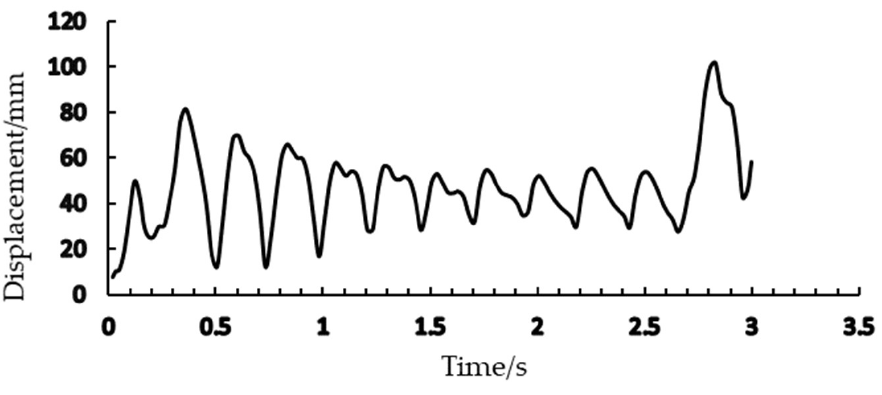
Figure 12. Simulated displacement results for the sprayer frame.